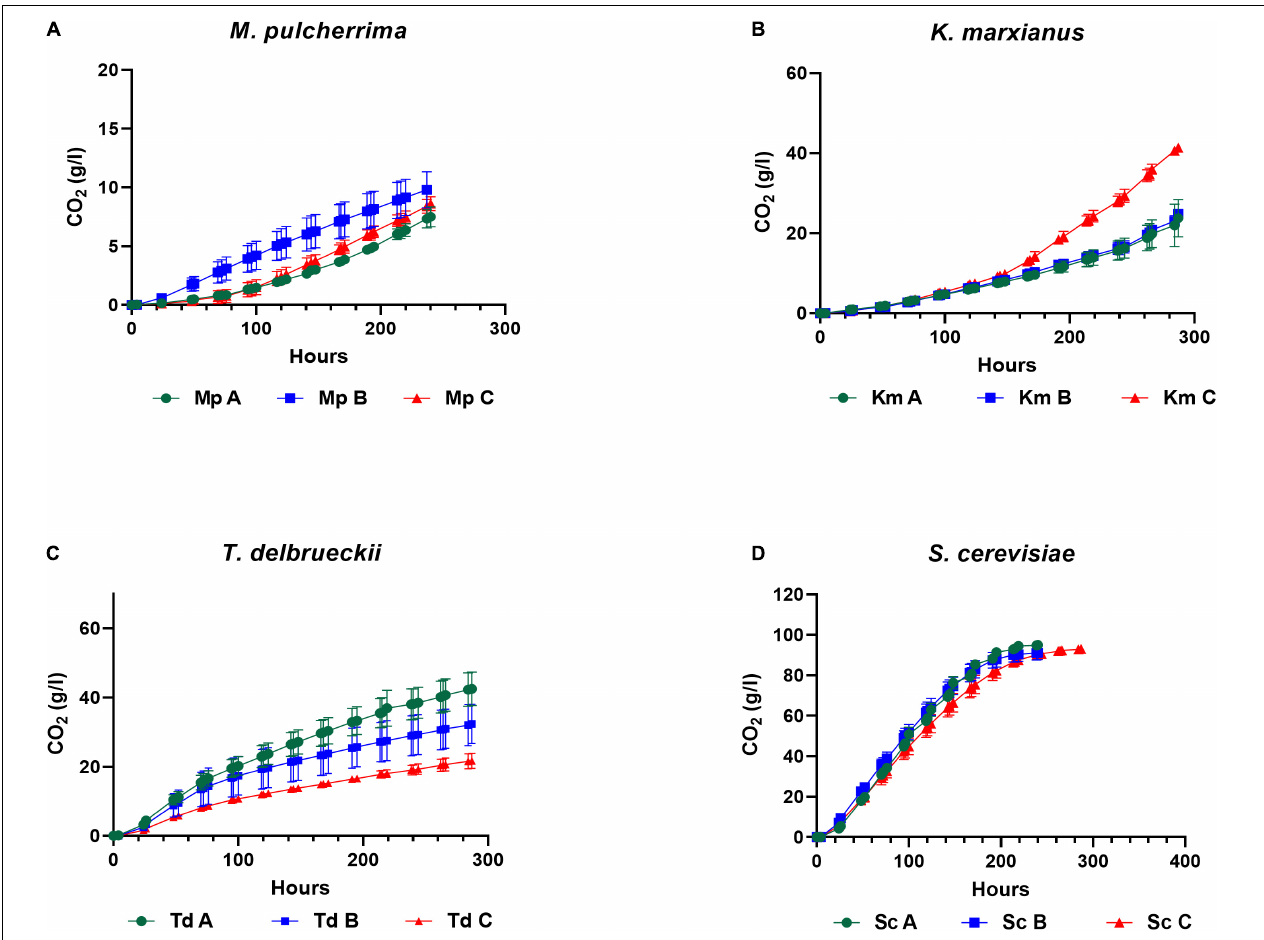
FIGURE 1 | Carbon dioxide production (weight loss) in M. pulcherrima (A) , K. marxianus (B) , T. delbrueckii (C) and S. cerevisiae (D) in Medium A (green), Medium B (blue) and Medium C